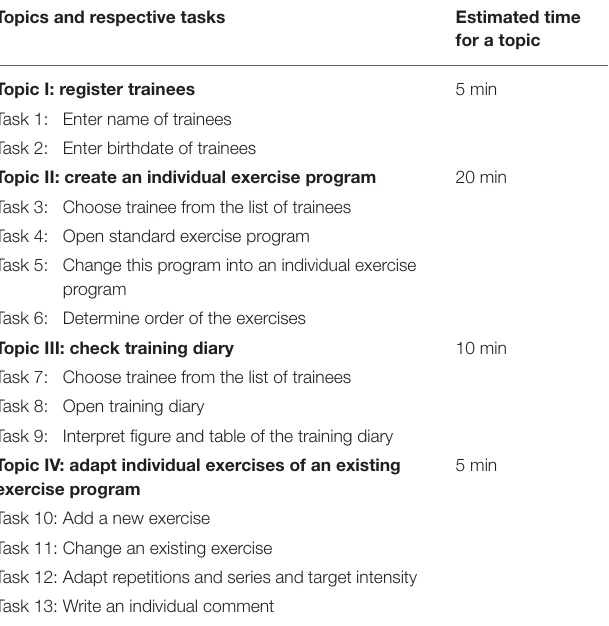
TABLE 2 | Tasks designed for the Trainees. Topics and respective tasks Estimated time